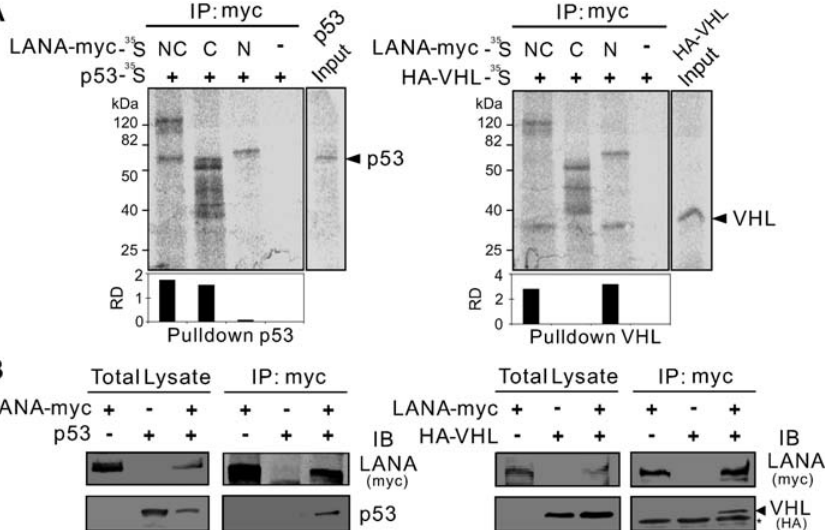
Figure 6. Distinct Domains of LANA Interact with Tumor Suppressors p53 and VHL (A) The amino-terminal domain of LANA binding VHL and carboxyl-terminal domain binding p53 in vitro. The cDNA encoding N (1–340 aa), C (762-1162 aa), and NC (1–327 ^ 929-1162 aa) LANA with myc tag, HA-VHL, and p53 were translated in a coupled transcription/translation system in the presence of [ 35 S]methionine. Fifteen-microliter aliquots of the translation products were immunoprecipitated with anti-myc antibodies. Immunoprecipitated proteins (IP) and a 1- l l aliquot of the transcription/translation reaction (Input) were fractionated by SDS-PAGE and detected by autoradiography. RD, relative density. (B) LANA is associated with p53 and VHL in cells. Saos-2 cells were cotransfected with expression vector encoding the indicated proteins. The lysates underwent IP using anti-myc antibodies. Crude extracts (left panels) and immune complexes (right panels) were separated by SDS-PAGE and IB with antibodies indicated. Asterisk indicates IgG heavy chain. DOI: 10.1371/journal.ppat.0020116.g006